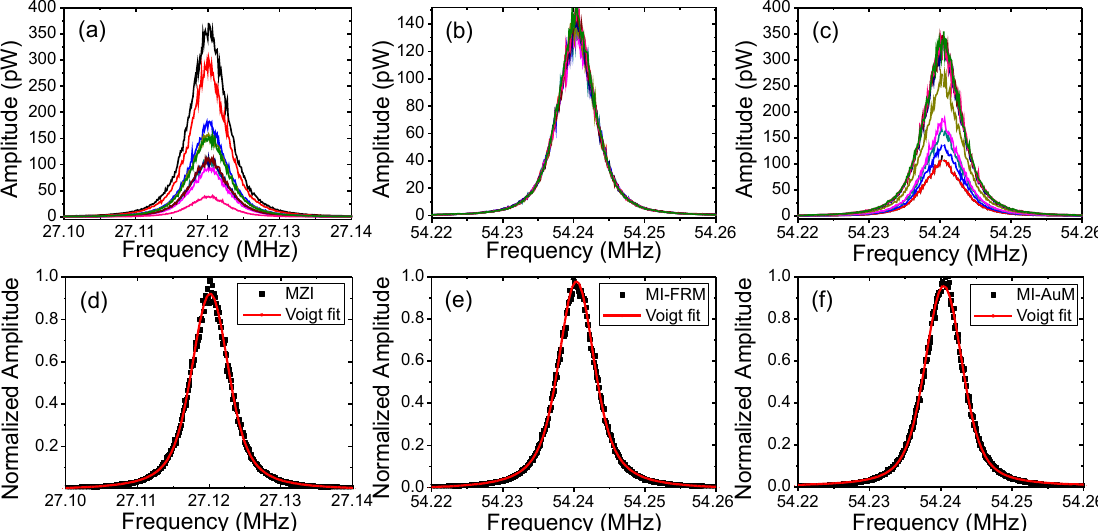
and ( b ) Gaussian, w linewidths extracted through Voigt L G